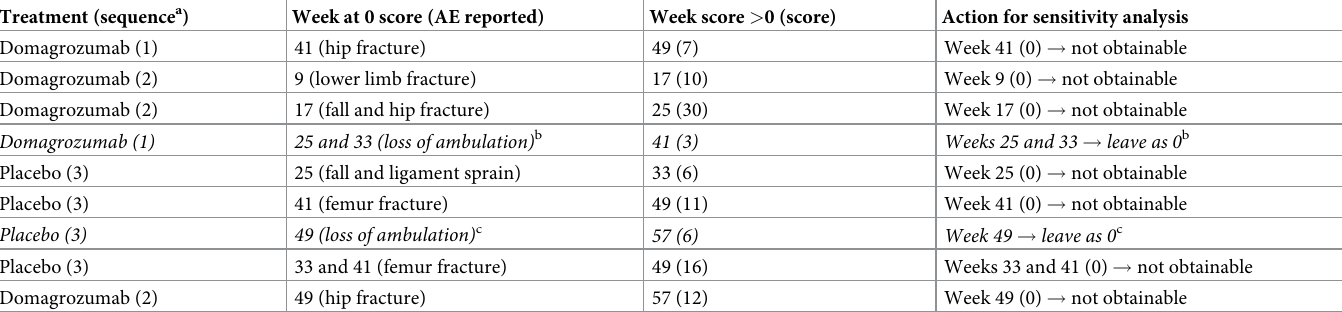
Table 1. Identified patients with temporary zero value for NSAA total score through week